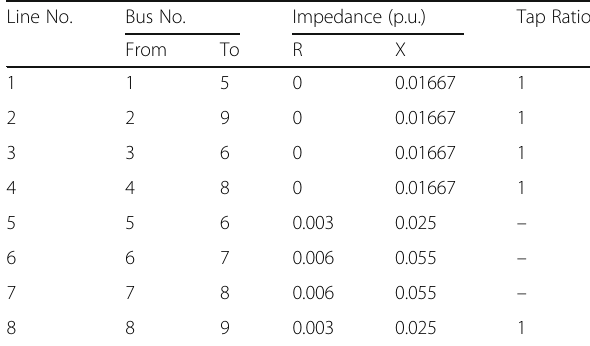
Table 3 Line information of the example system Line